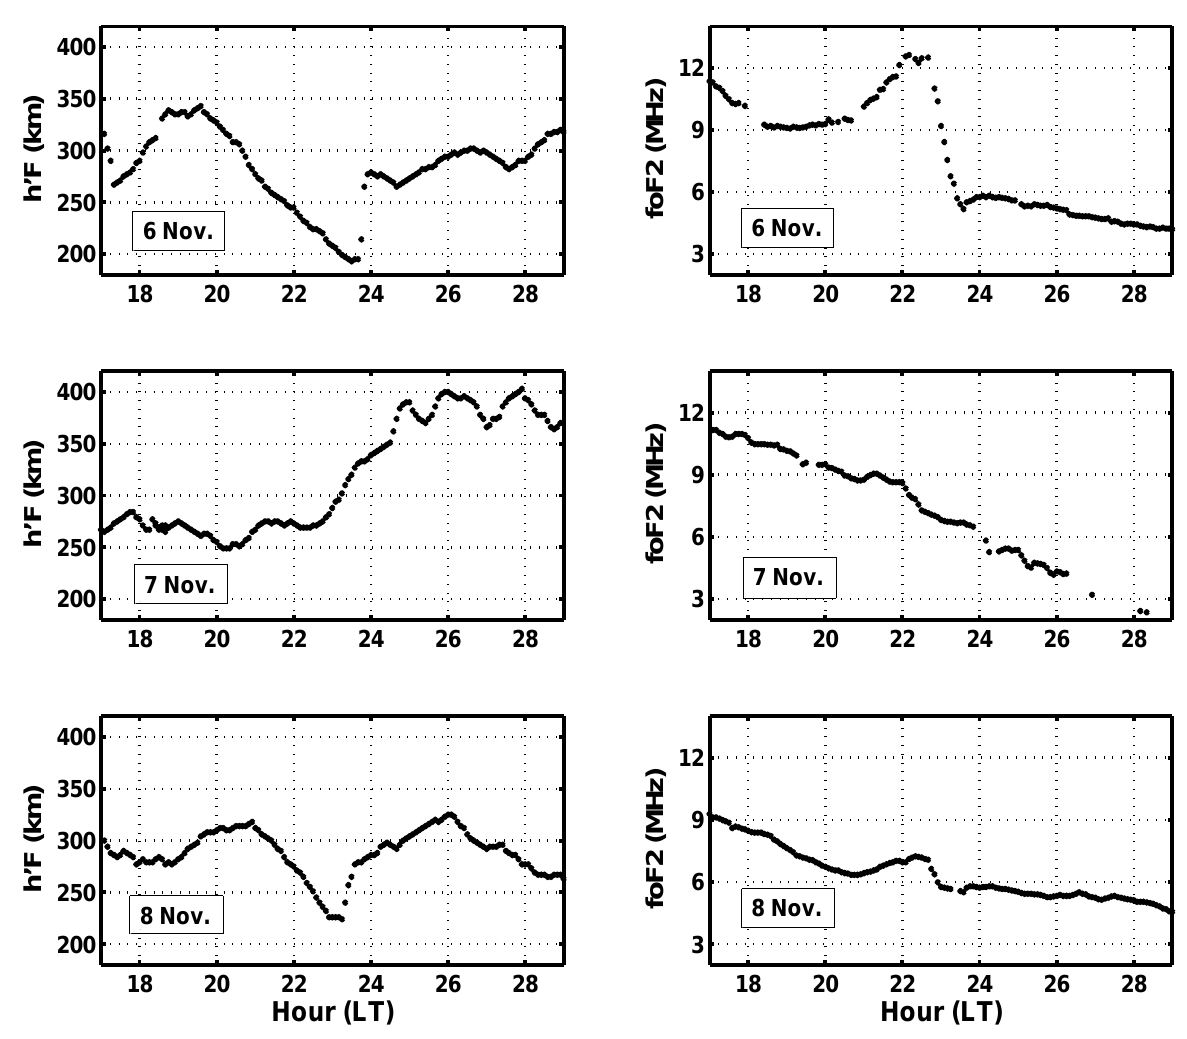
Fig. 9. Variations in base ionospheric height h 0 F and fo F2 at Vanimo over the period 6–8 November 1997. Normal sunset vortex behaviour on the 6 November was stopped on the night of the 7 November preceding a negative ionospheric storm day. A partial recovery occurred on the following